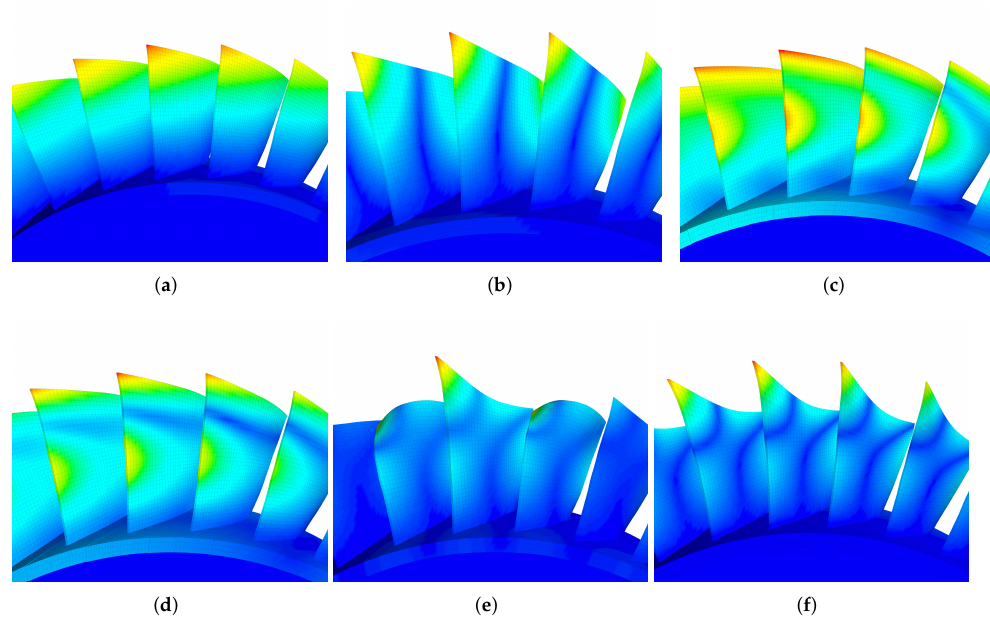
Figure 4. Blade deformation of different modal families. The colour represents the absolute value of the overall displacement. ( a ) 1st family, NDI = 2; ( b ) 2nd family, NDI = 2; ( c ) 3rd family, NDI = 2; ( d ) 4th family, NDI = 2; ( e ) 4th family, NDI = 14; ( f ) 5th family, NDI =